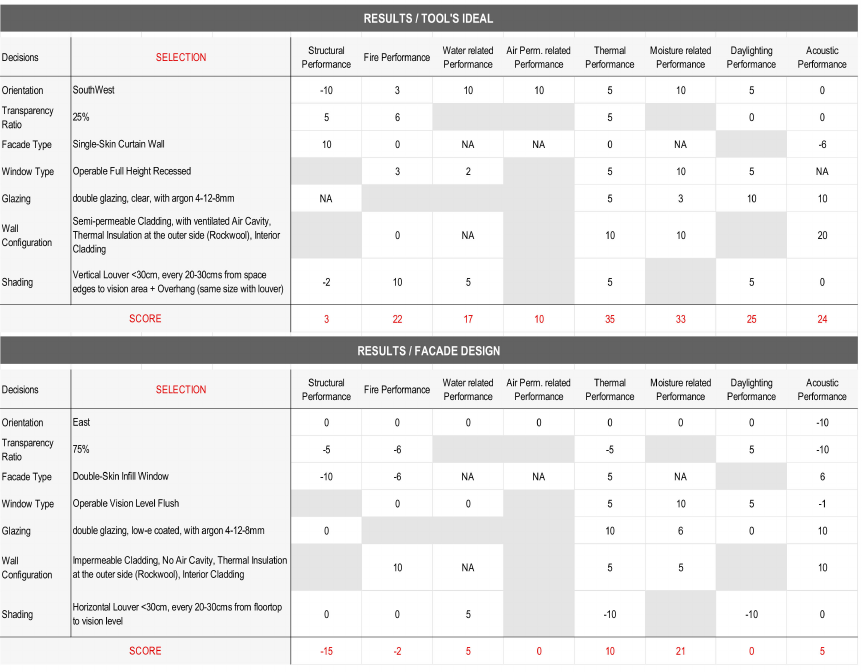
Figure 7. Design decisions and respective scores (screenshot from the